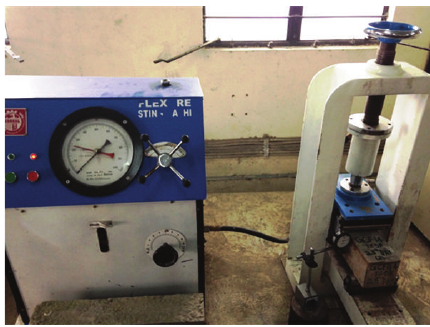
Figure 3: Third point loading arrangement in flexural strength testing